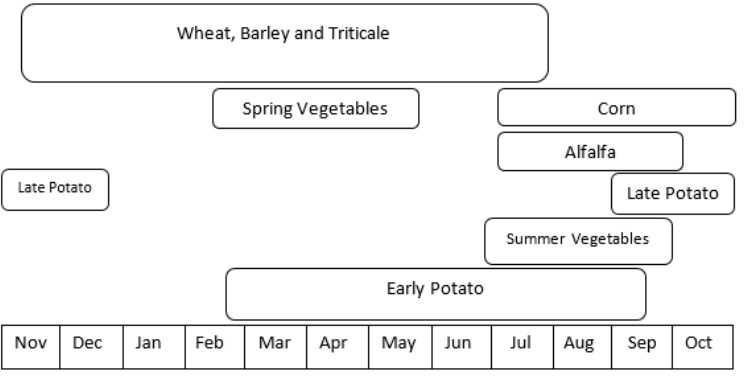
Figure 2. Different crops calendars at the Bekaa plain (adopted from USAID [25]).